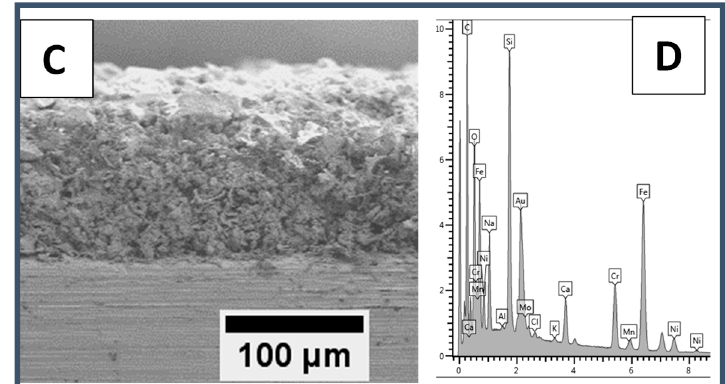
Figure 1. PEEK/BG/h-BN coatings produced by EPD at a voltage of 90 V for 90 s and sintered at 375 °C; ( A ) SEM image of the top surface, ( B ) EDX mapping at the cross-section, ( C ) SEM image at a cross-section, and ( D ) EDX analysis.